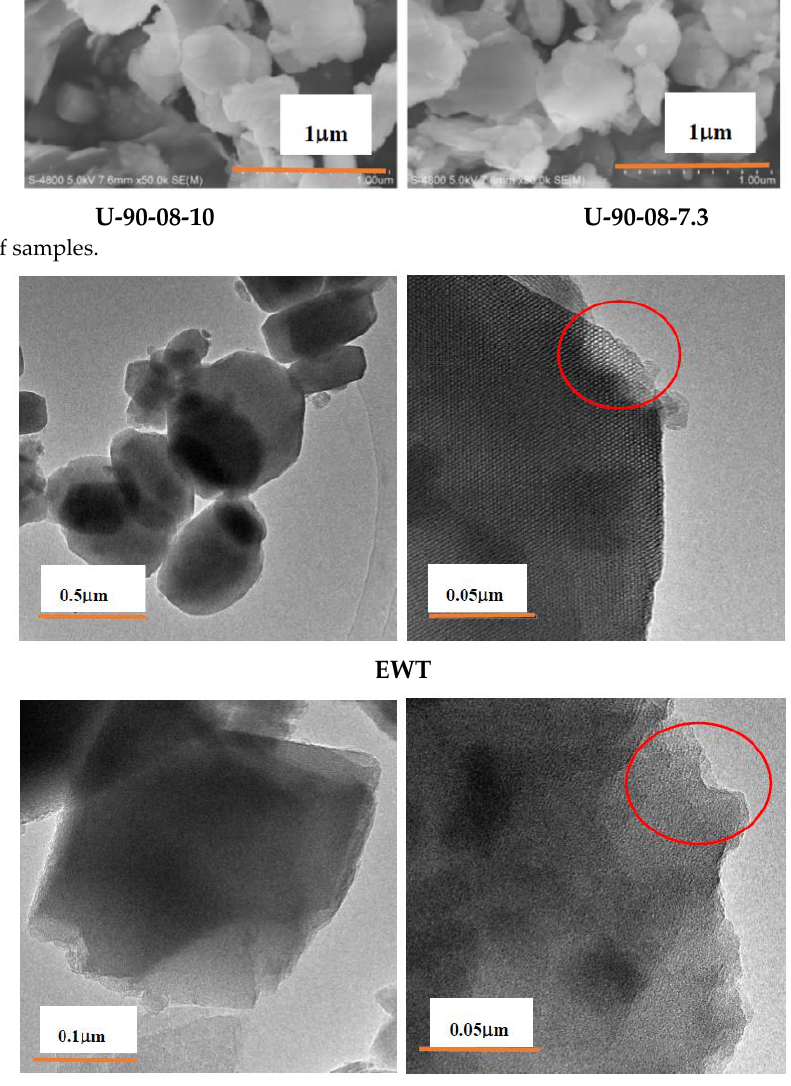
Figure 8. ( a ) SEM ( b ) and TEM images of samples.